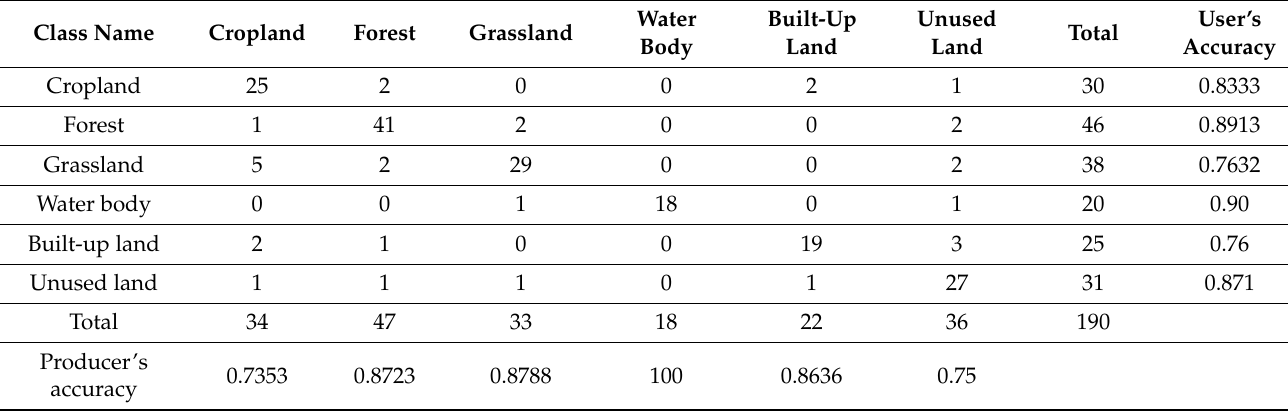
Table 1. Error matrix for the classification method in 2003.